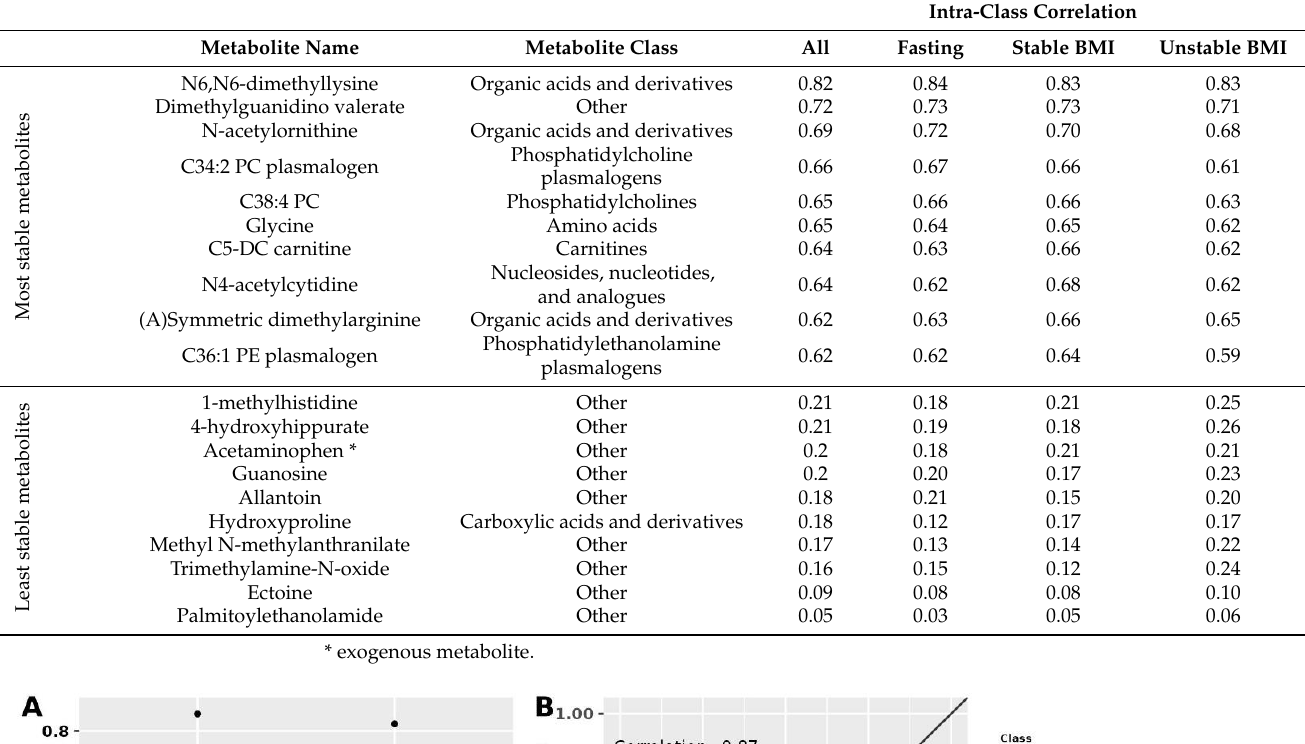
Table 3. Most and least stable metabolites. ICCs were estimated among four participant subgroups: all participants ( n = 1184 repeated samples and n = 696 unique samples), fasting participants ( n = 765 repeated and n = 544 unique samples), and among participants with stable ( n = 706 repeated samples) or unstable BMI ( n = 478 repeated samples). The stable BMI group includes participants with ≤ 2 kg/m 2 difference in BMI between the two blood collections. The unstable BMI group includes participants with >2 kg/m 2 difference in BMI between the two blood collections.